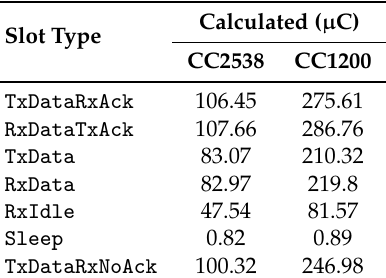
Table 19. Calculated charge drawn for each slot type, used in the simulator experiments.